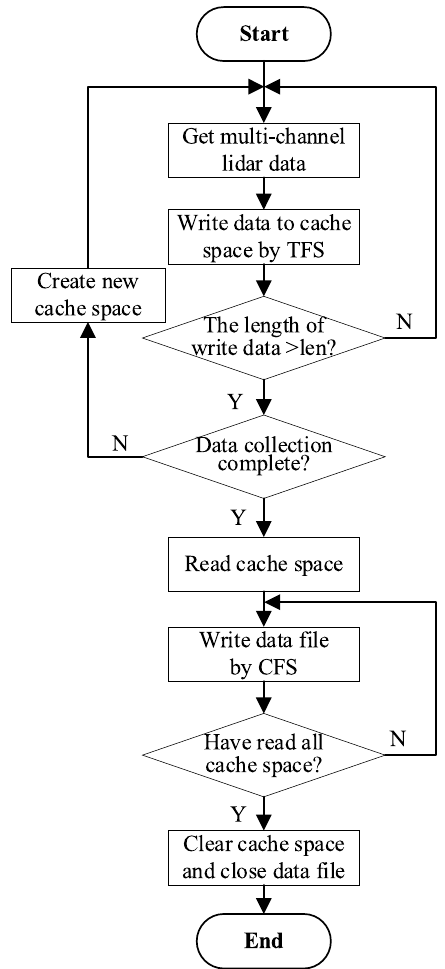
Figure 8. The process of conversion and storage